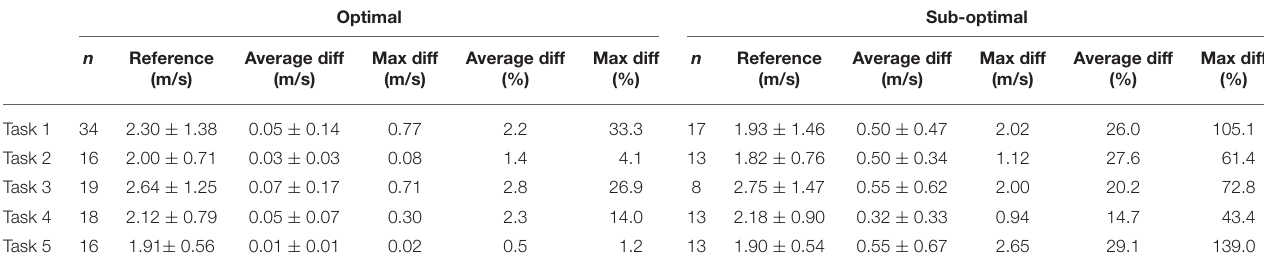
TABLE 4 | Difference between the LPS and reference system for average speed, for optimal and sub-optimal condition